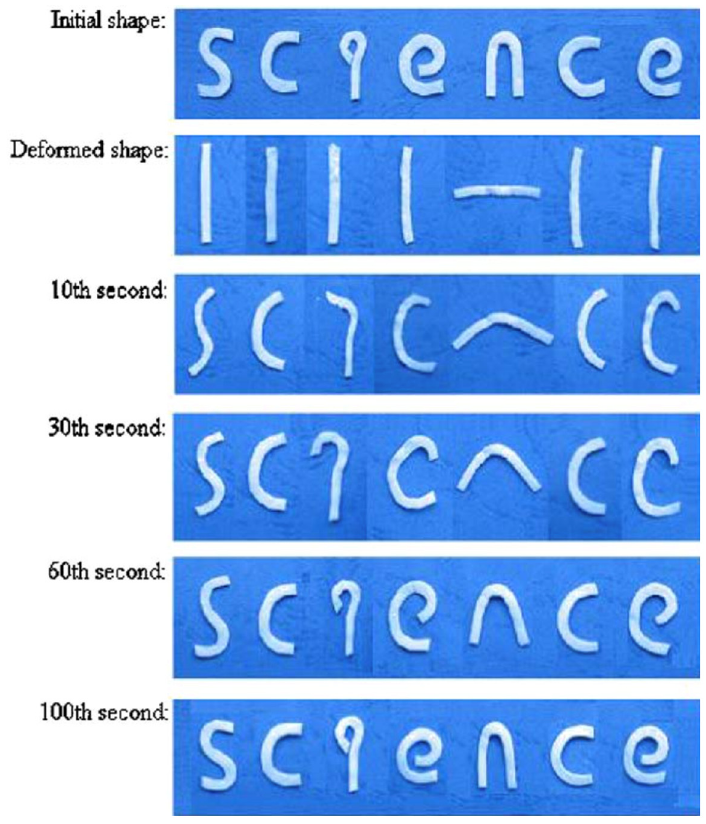
Figure 11. The photographs were taken with a digital camera to depict the progression of shape recovery of the term “science” composed of PDLLA/HA composite. (Reproduced with permission from [107], Elsevier, 2006).